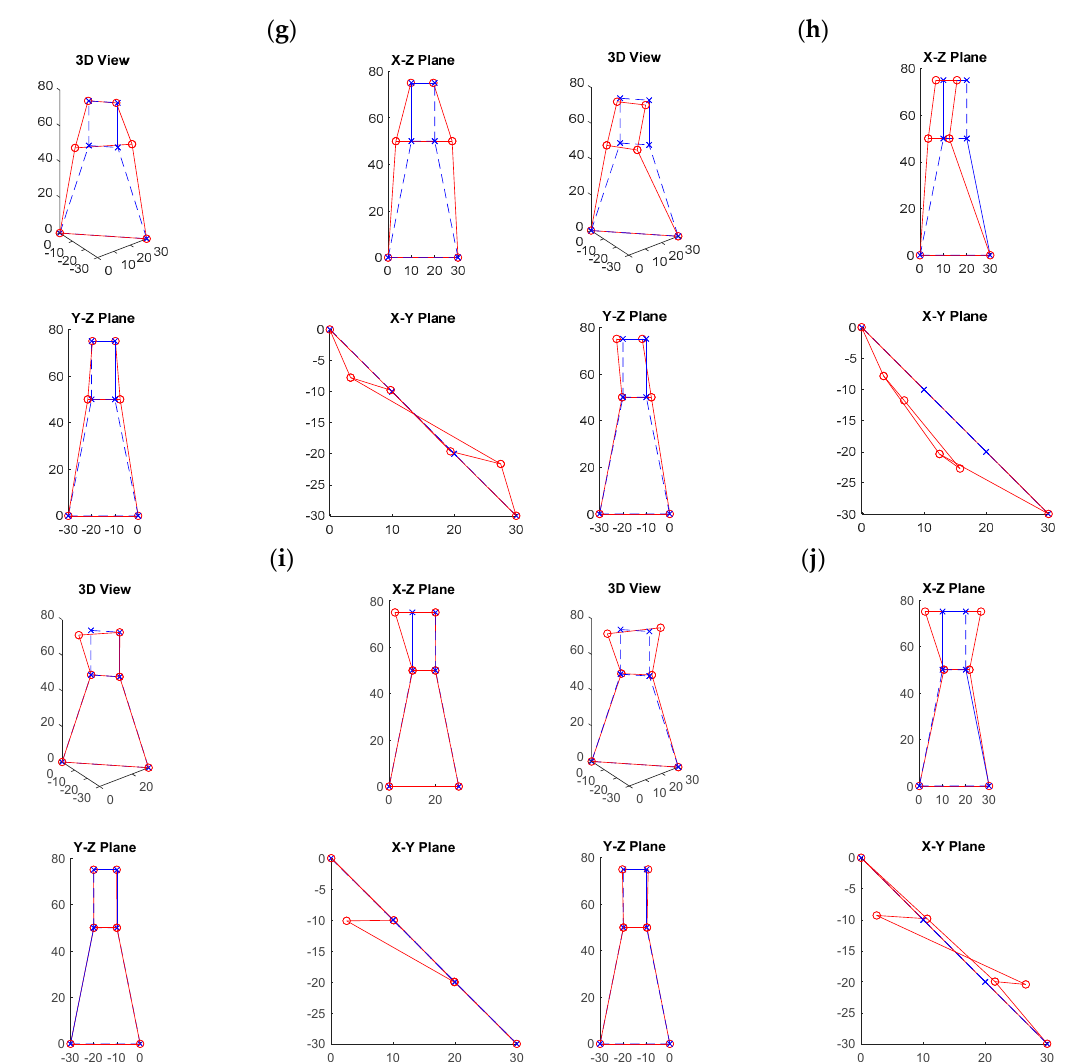
Figure 10. The mode shapes of the ten target modes with modal frequency: ( a ) 2.03 Hz; ( b ) 2.43 Hz; ( c ) 2.51 Hz; ( d ) 3.26 Hz; ( e ) 8.26 Hz; ( f ) 15.33 Hz; ( g ) 18.67 Hz; ( h ) 21.39 Hz; ( i ) 24.36 Hz; and ( j ) 31.08 Hz.